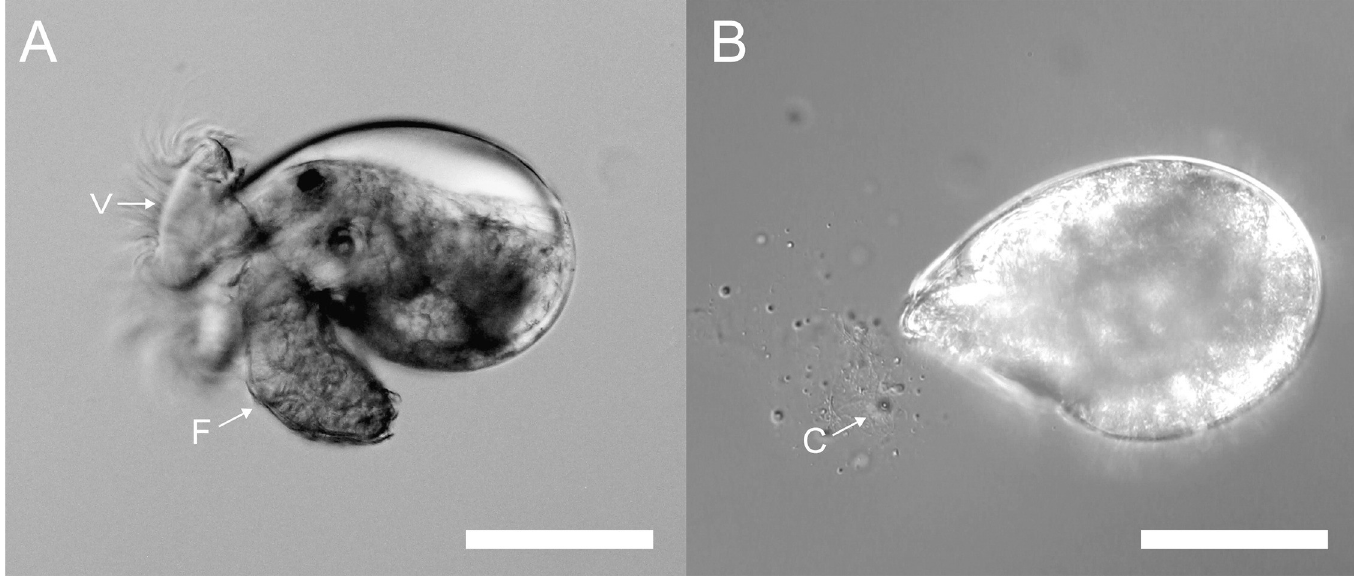
Fig 6. Larva of P . sibogae lose cilia when exposed to the semi-purified tailocin arrays from P . luteoviolacea . (A) Untreated larva from P . sibogae showing velar cilia; F: foot, V: velum. (B) Contracted larva exposed to tailocin arrays from P . luteoviolacea sheds cilia and ciliated cells (C). Scale bar: 100 μ m.